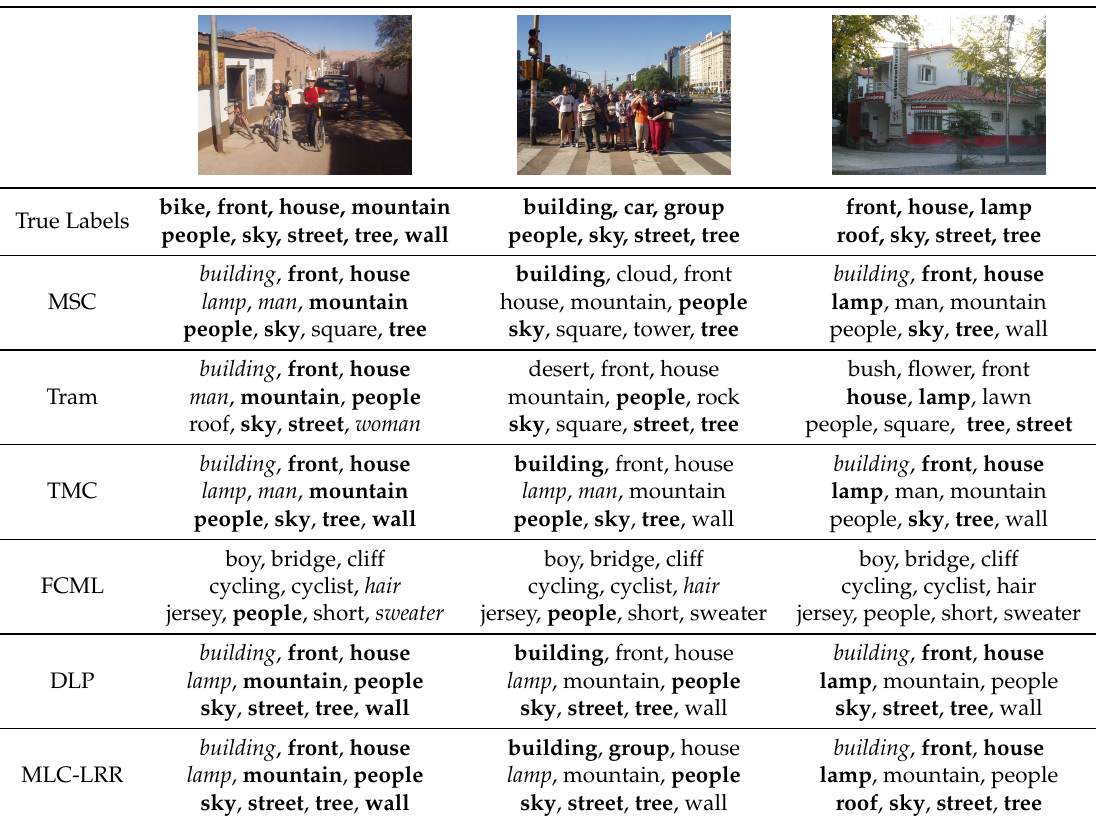
Table 5. Predicted labels for exemplar images in IAPRTC-12 [59]. The ground-truth labels are highlighted in bold font, and the potentially correct labels are in italic